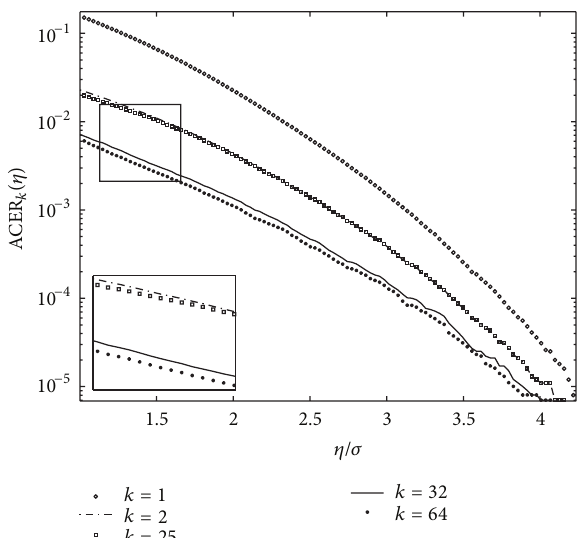
Figure 14: Comparison between ACER estimates for different degrees of conditioning for the narrow-band time series.